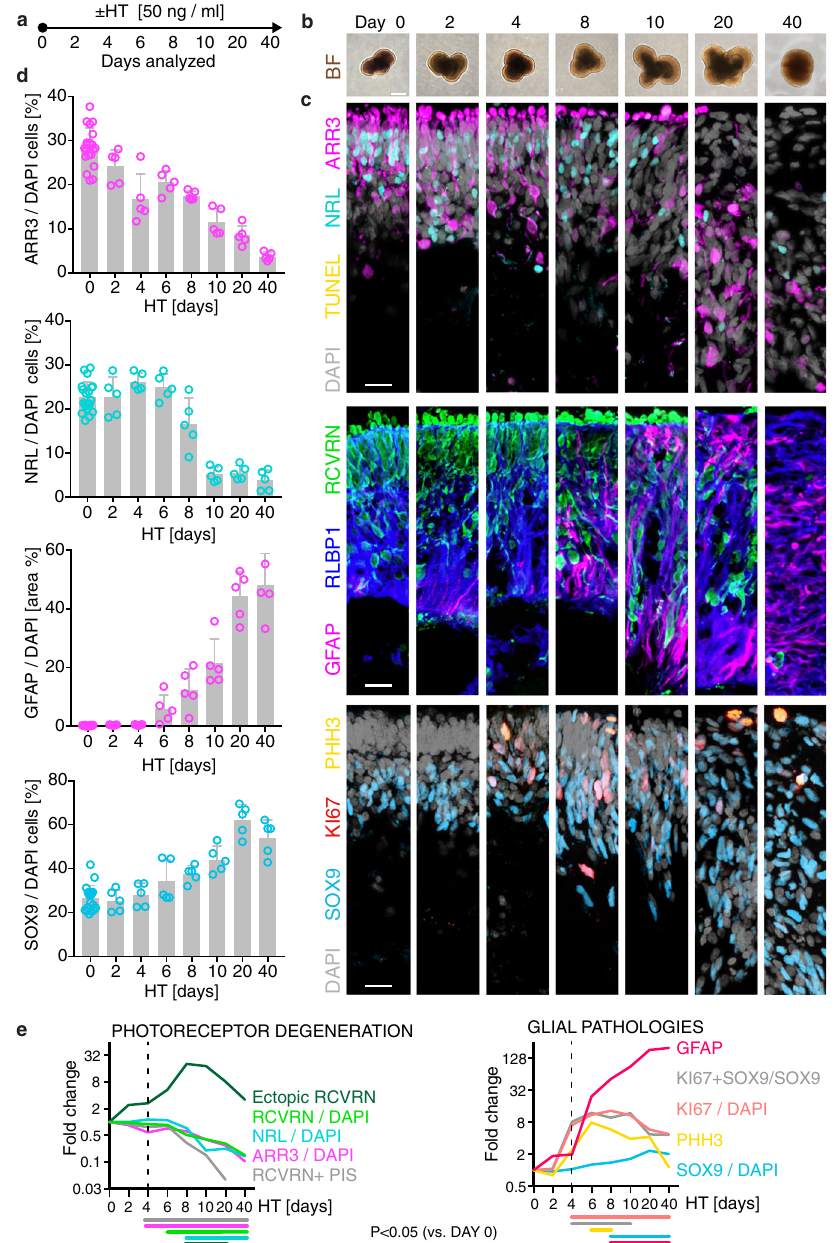
Fig. 6 | Kinetics of HBEGF-TNF-induced pathogenesis: simultaneous and tem- porallyprogressivephotoreceptorandglialpathologies.a Experimentaldesign: HBEGF-TNF (HT) was applied daily and HROs were analyzed at indicated time- points. b Representative bright- fi eld images of HT-treated HROs in culture. c Representative images and ( d ) quantitative analysis of photoreceptor and glial pathology development: cone (ARR3) and rod (NRL) photoreceptor (RCVRN) cell loss and cell ectopy, as well as loss of photoreceptor inner segments (PIS); gliosis (GFAP),cellproliferation(KI67,PHH3)ofMG(SOX9),andtotalcellnumber(DAPI). See Supplementary Figs. 12 and 13. Graphs show mean ±SD, and circles represent